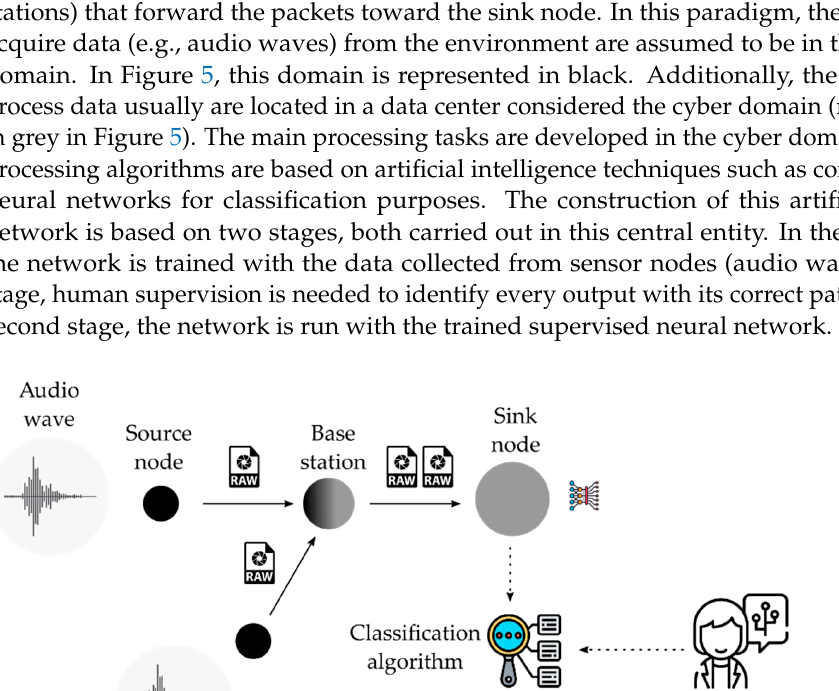
Figure 6. Decentralized architecture. In contrast with both the first and second approach, the cyber-physical systems (CPS) approach combines the execution of the algorithms in both the physical and the cyber domains. Figure 7 shows an example of how a CPS architecture could fulfill the require- ments of a classification problem while minimizing the drawbacks found in the prior ap- proaches.